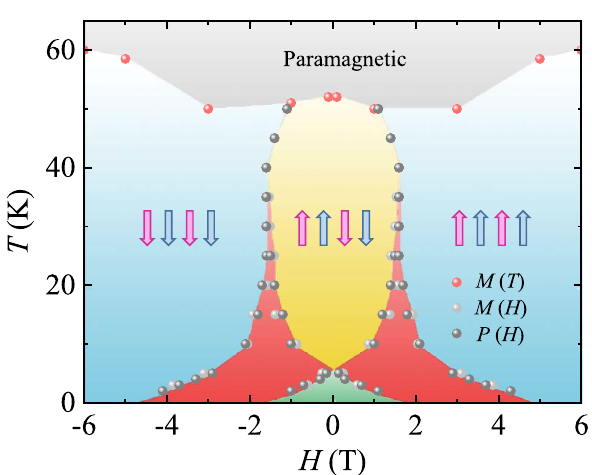
′ ′ ( 0T ) ( H ) − ε × 100 perpendicular to the c axis ε ′ ( 0T )